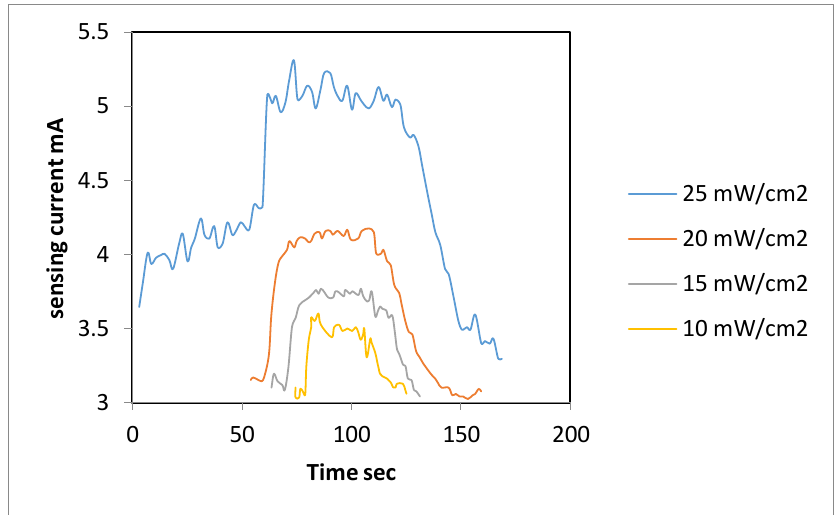
Figure 6: Illustrated the sensing current to exposer time for different power densities (10, 15, 20, 25) mW/ 𝑐𝑚 2